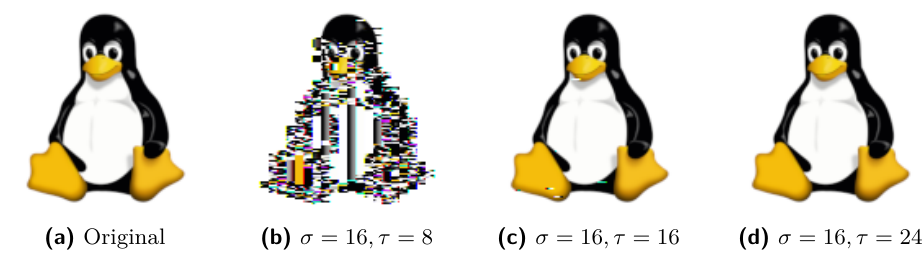
Figure 10: Visualization of the impact of the correctness parameter τ . A 128 × 128 image of Tux (Figure 10a) has been encrypted and subsequently decrypted with K thisisasecretkey using SCB [ AES-128 , [ · ] τ ◦ SHA-256 ] for κ = n = 128, σ = 16,